Question: What style of plot is this figure drawn as?
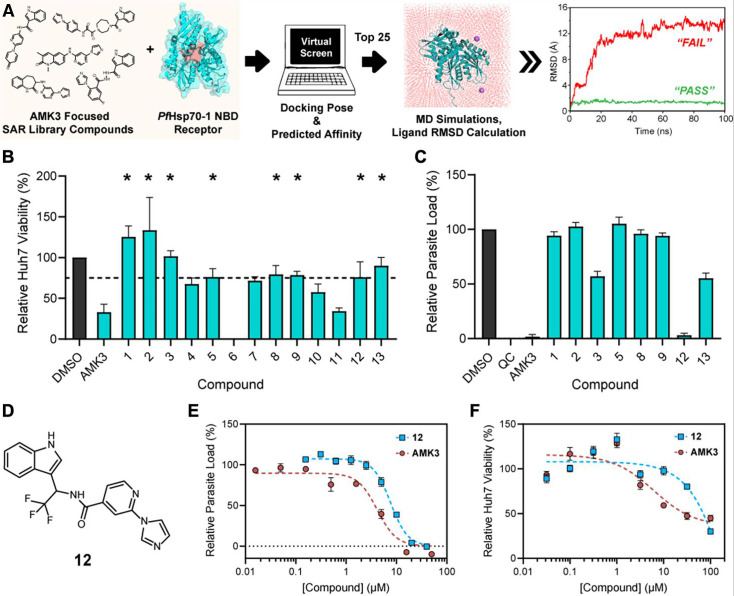
Answer: line